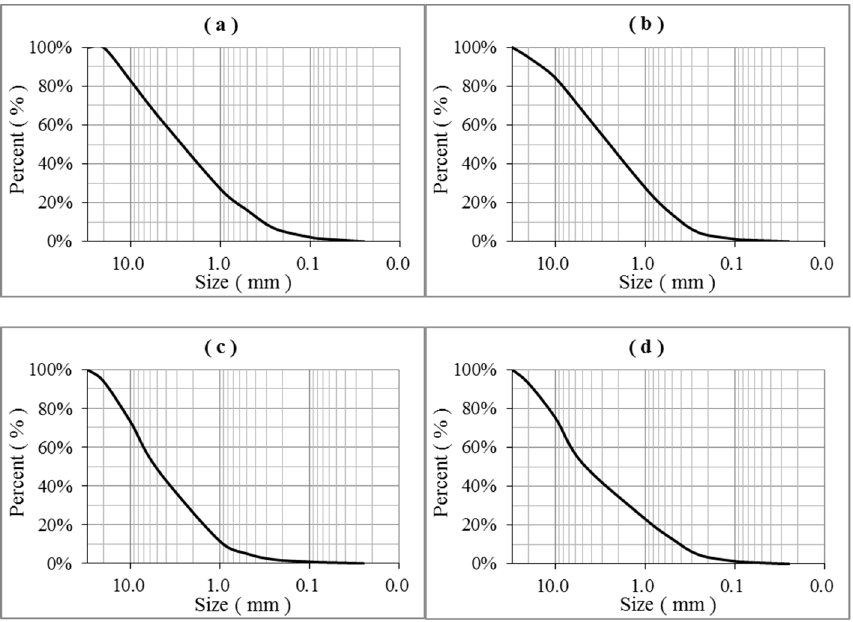
Figure 3. The particle gradation curves (( a ) M01; ( b ) M02; ( c ) M03; ( d ) M04).